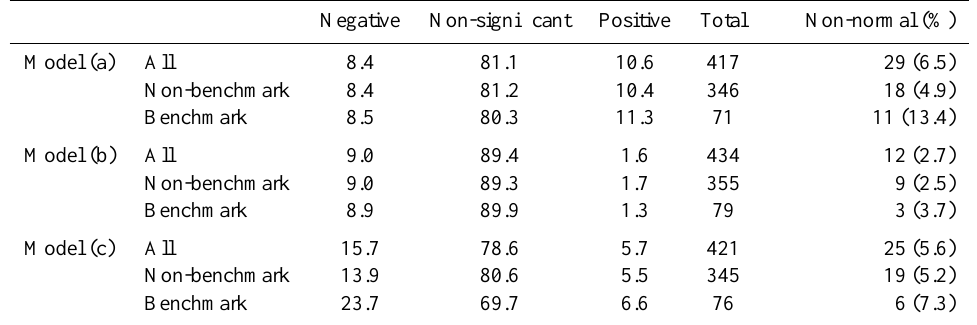
Table 3. Comparison of the proportions of significant and non-significant estimated slope coefficients in the whole data set, the non-natural series and near-natural series – summer maxima